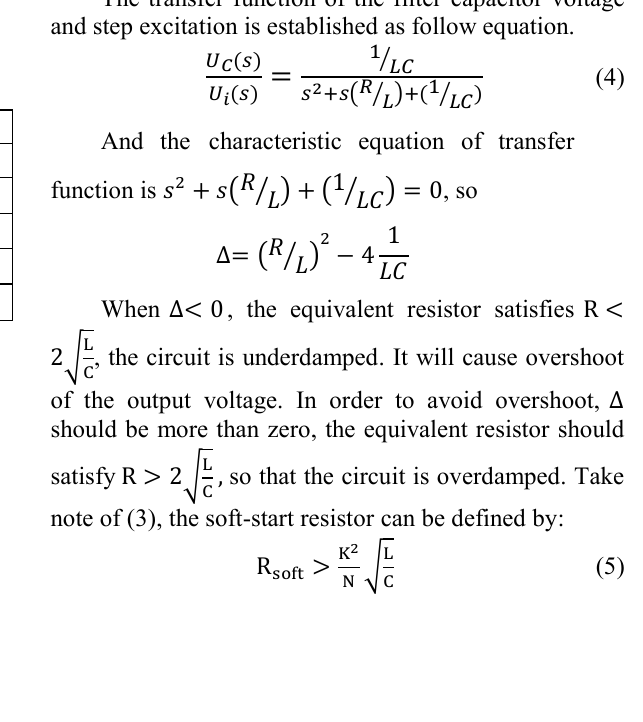
Fig. 3. The DC equivalent circuit of rectifying module.